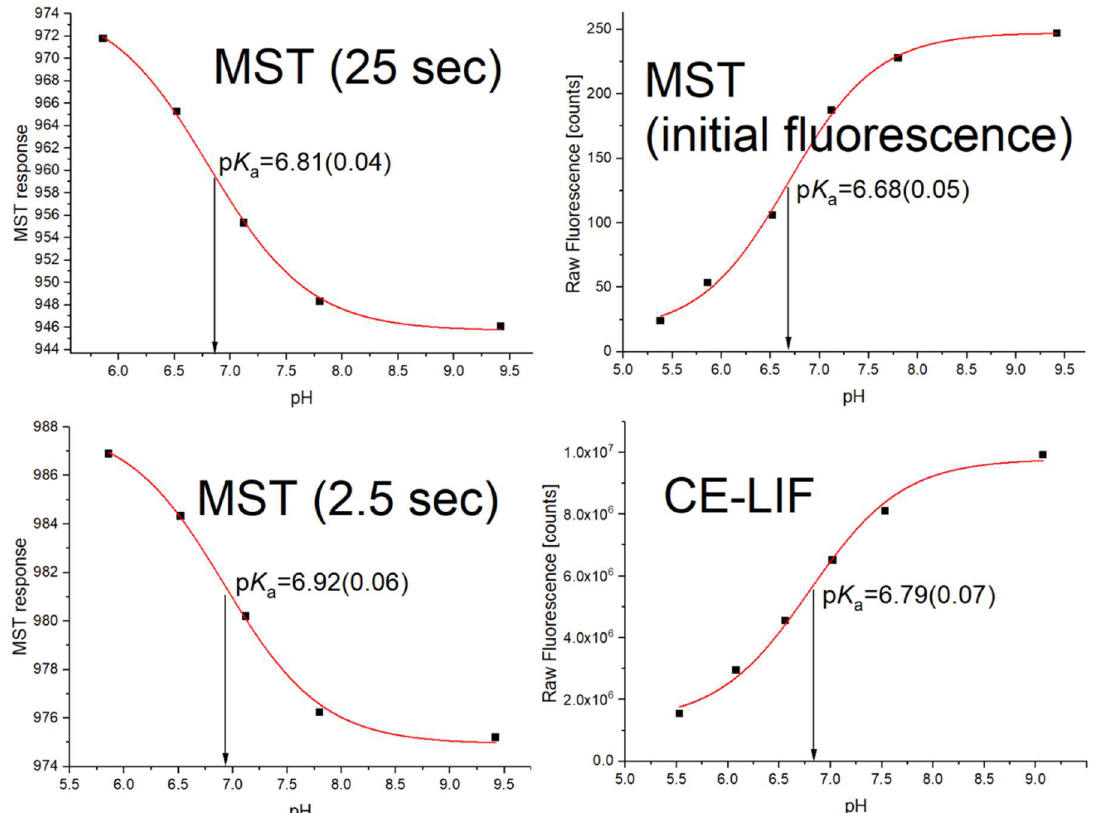
Figure 4. Comparison of the p K a values determined on the basis of the thermophoresis/TRIC at different heating times (25 s and 2.5 s), and the reference values obtained by methods using fluorescence but independent of the thermophoresis/TRIC (MST and CE-LIF). The error of p K a determination is given in parentheses. The same temperature (22 °C) was set up in the MST and CE-LIF instruments.